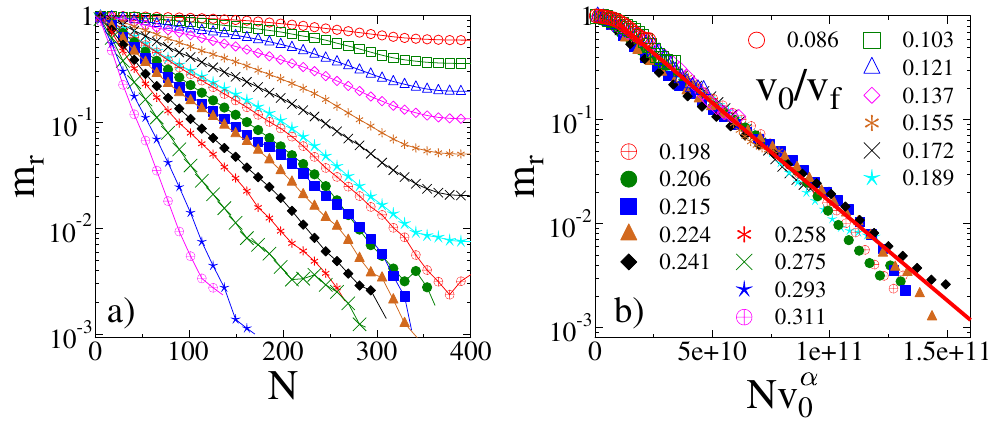
Figure 4. ( a ) Average mass of the residue m r as a function of the impact number N for several impact velocities v 0 below the fragmentation critical point v f . Panel ( b ) shows that by rescaling the horizontal axis, curves of different v 0 values can be collapsed onto one single master curve. Note that data of the lowest impact velocities (highest remaining mass) are in the upper left corner at the start of the master curve. Straight line represents the exponential form of the scaling function (cid:31) m r ( x ) of Eq. (1). The legend for ( a ) and ( b ) is given in ( b